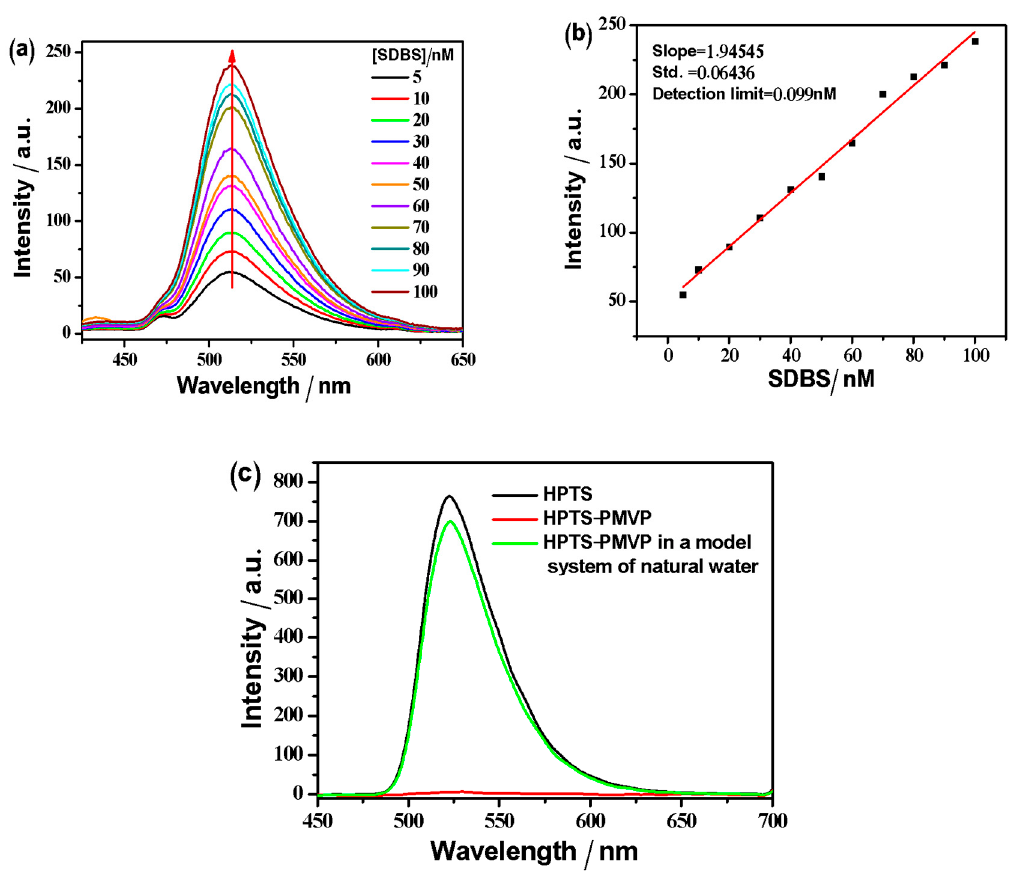
Figure 6. ( a ) Emission spectra of the HPTS/PMVP 41 - b -PEO 205 complex in water in the presence of increasing amounts of SDBS; ( b ) The relationship between the emission intensity and the concentration of SDBS from 5 to 100 nM. R = 0.9903; ( c ) Emission spectra of the HPTS, HPTS/PMVP 41 - b -PEO 205 complex and polyion complex in a model system of natural water which contains different surfactants, including SDS, SL, SDBS and simple organic ions. [SDBS] = 100 nM; [SDS] = [SLS] = 200 nM; [KCl] = [NaCl] = [KNO 3 ] = 0.2 mM. PMVP is the abbreviation of PMVP 41 - b -PEO 205 . [PMVP 41 -b -PEO 205 ] = 0.6 μ M; [HPTS] = 0.1 μ M. Excitation wavelength: 405 nm.